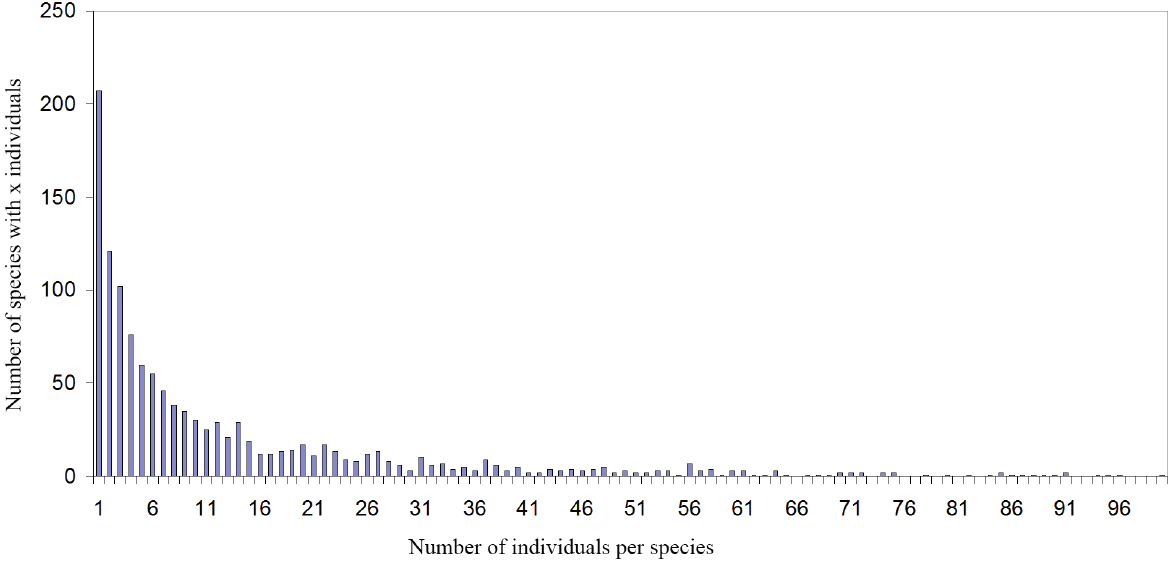
Figure 2 - Frequency of area of occurrence for species of Sapotaceae (data from Pennington